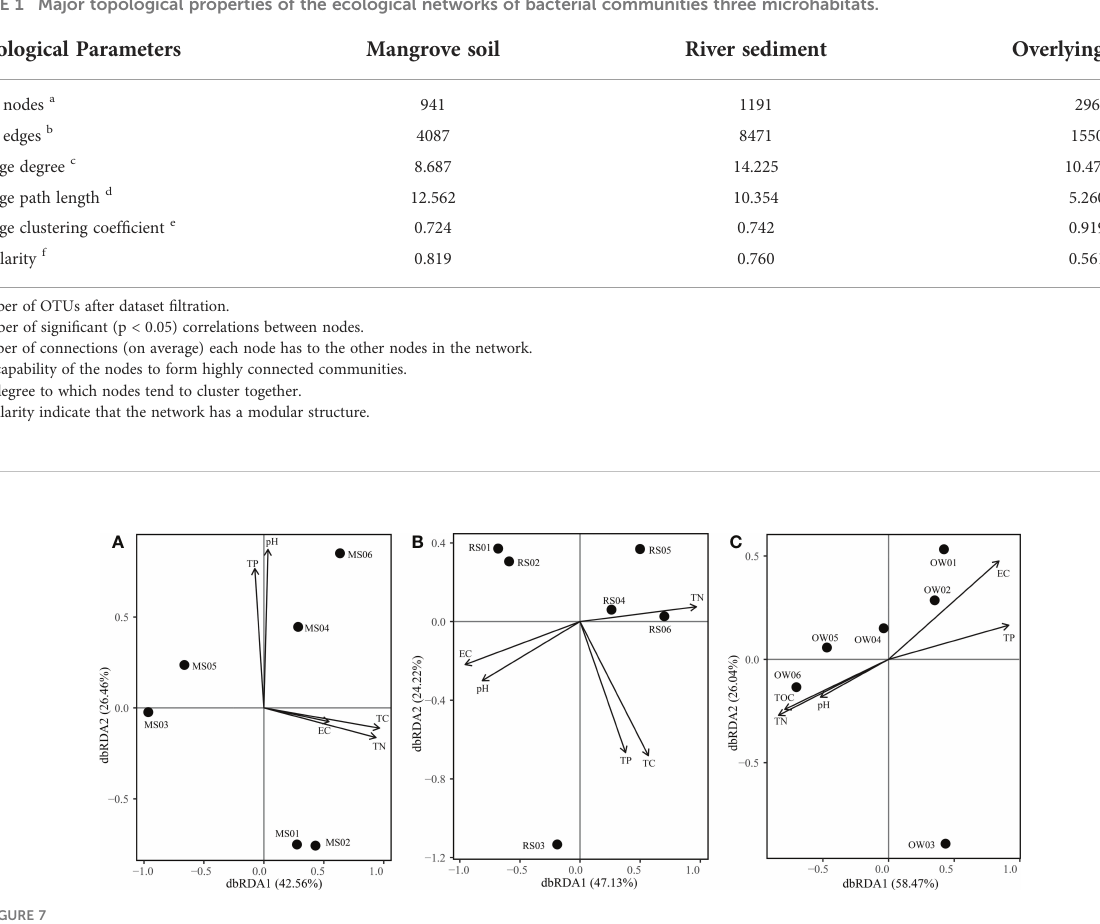
TABLE 1 Major topological properties of the ecological networks of bacterial communities three